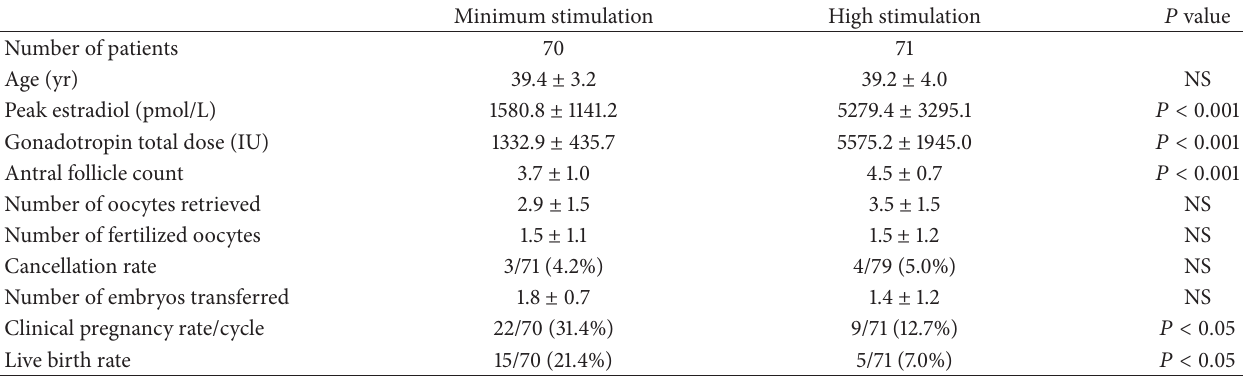
Table 1: Data comparison of minimal stimulation and high-dose stimulation protocols for low responders. Not significant results are denoted by